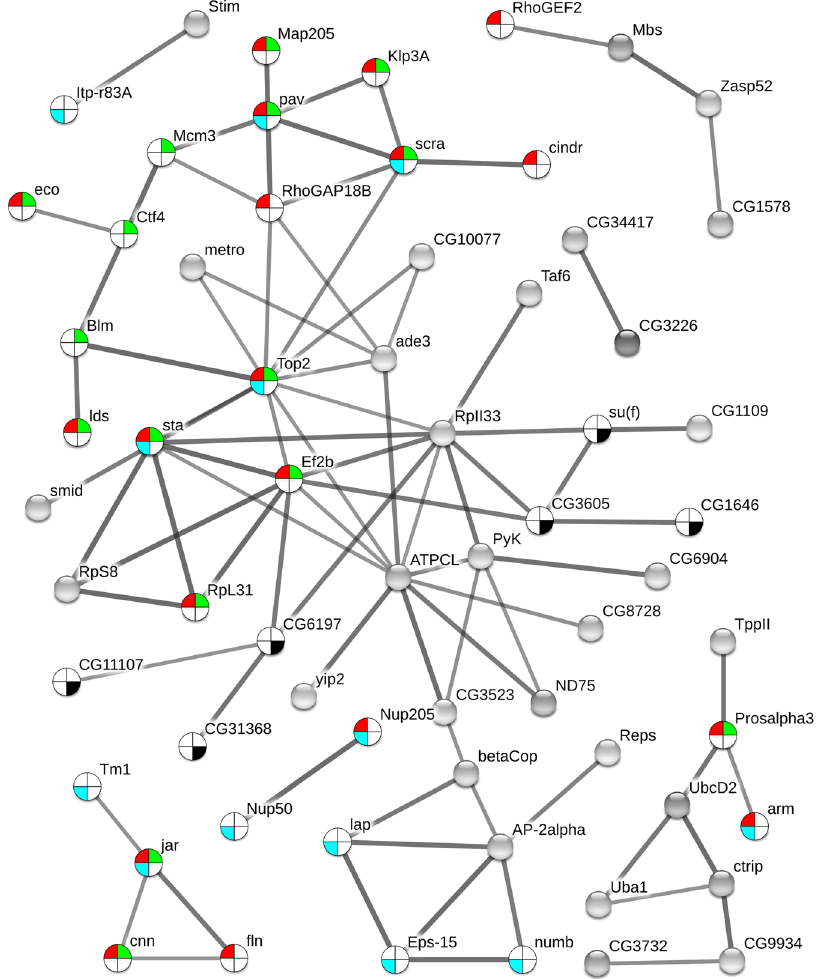
Figure 7. Phosphoprotein interaction network resulting from the set of proteins positively regulated by phosphorylation events [list CA ( + ) ] with acclimation. The phosphoproteins set was analyzed for putative protein-protein interactions using STRING program with default settings except that we only considered high confidence interactions (with score > 0.7). Disconnected nodes are not shown in the network. Phosphoproteins involved in the four major GO-terms superclusters detected in REVIGO (see Fig. 8) are highlighted within the network with different colors: cytoskeleton organization (red), mitotic cell cycle (green), cellular localization (blue), and mRNA processing